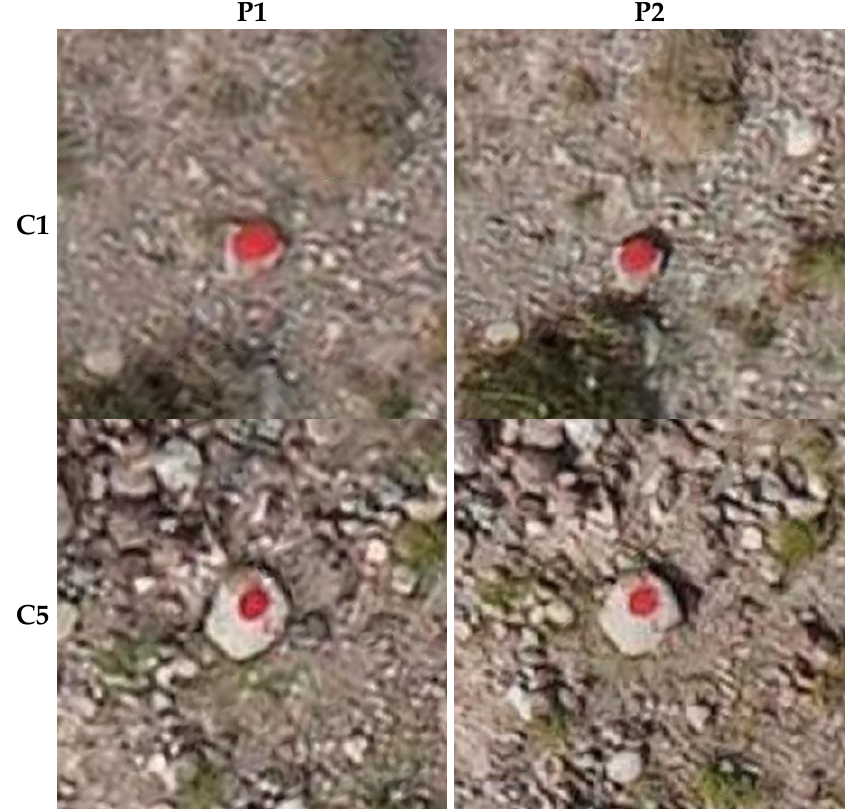
Figure 12. The sprayed stones in the two sequential 3D model. P1 represents the 3D of the first period, and P2 represents the second period. Table 3. The displacement and difference of the sprayed stones in the two sequential 3D models.